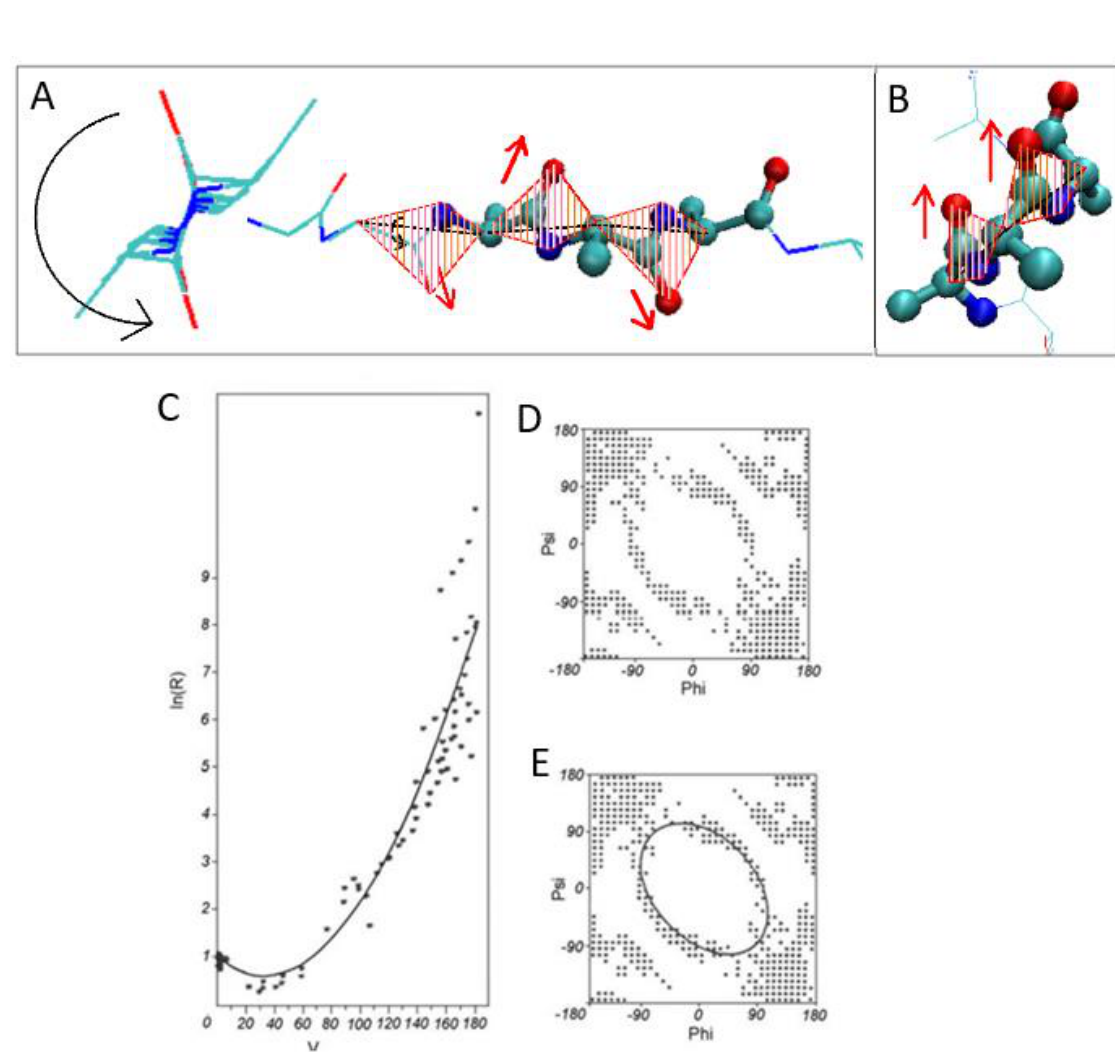
Figure 14. The main steps for generating the early-stage model (see the description in text). ( A ) — β -structural form with peptide bond planes marked by red lines visualizing the antiparallel orientation of C=O groups in two sequential residues. Left picture with the arrow visualizes the V angle = 180 degrees. ( B ) — α -helix with peptide bond planes marked by red lines visualizing the V angle = 0 degrees. ( C ) — parabolic dependence of R (logarithm scale) on V angle. ( D ) — distribution of points satisfying the condition defined by the parabola in ( C ). ( E ) — the elliptical path.